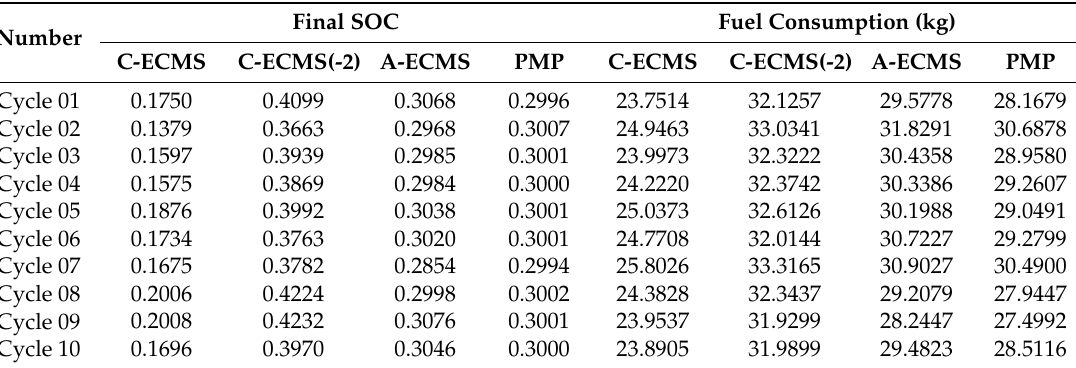
Table 7. Comparison statistics with initial SOC = 0.90.